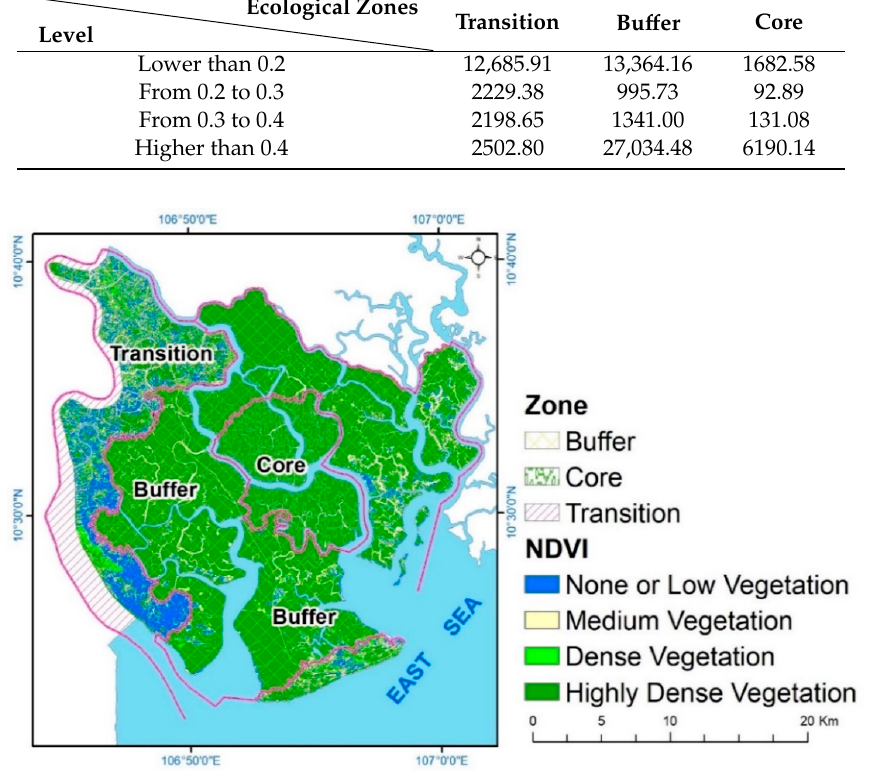
Figure 2. Spatial distribution of the mean Normalized Difference Vegetation Index (NDVI) classifications on three ecological zones during 2015–2019 period.